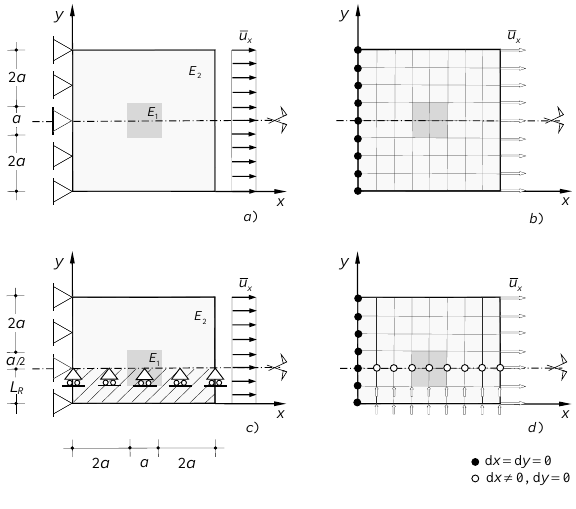
Figure 1: Nonlocal elastic symmetric square plate under tension with piecewise constant Young modulus. Mechanical model, boundary and loading conditions of: a ) whole structure; c ) enlarged symmetric model of the structure; b ) and d ) sketches of the NL-FE meshes adopted for models a) and c), respectively.